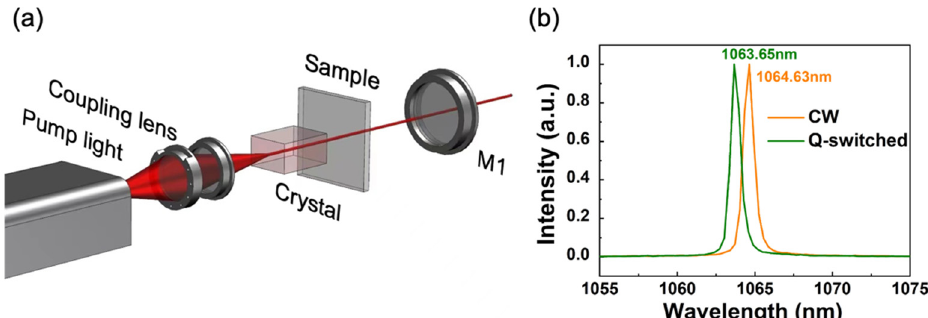
Figure 8. ( a ) The schematic of the experimental setup for the passively Q-switched operation. M1 was a concave dichroic mirror used as an output coupler. ( b ) Emission laser spectra of continuous wave (CW) and Q-switched laser modulated by perovskite nano-composition.